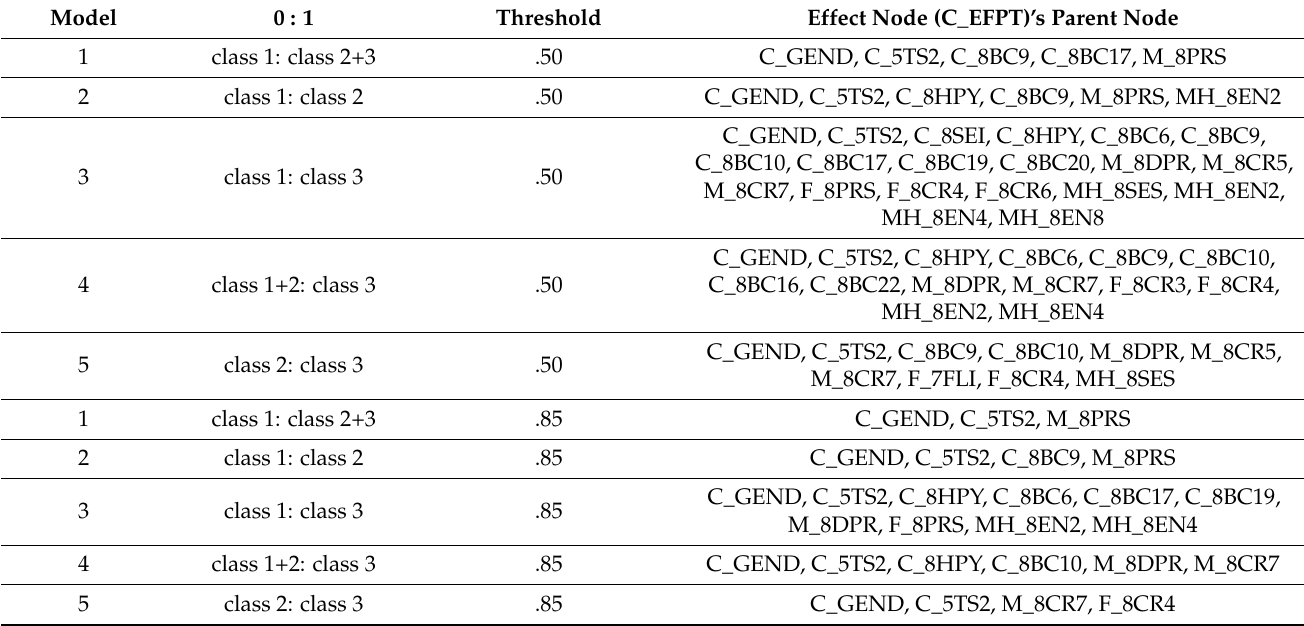
Table 5. Predictors of EFD modeling by Bayesian network